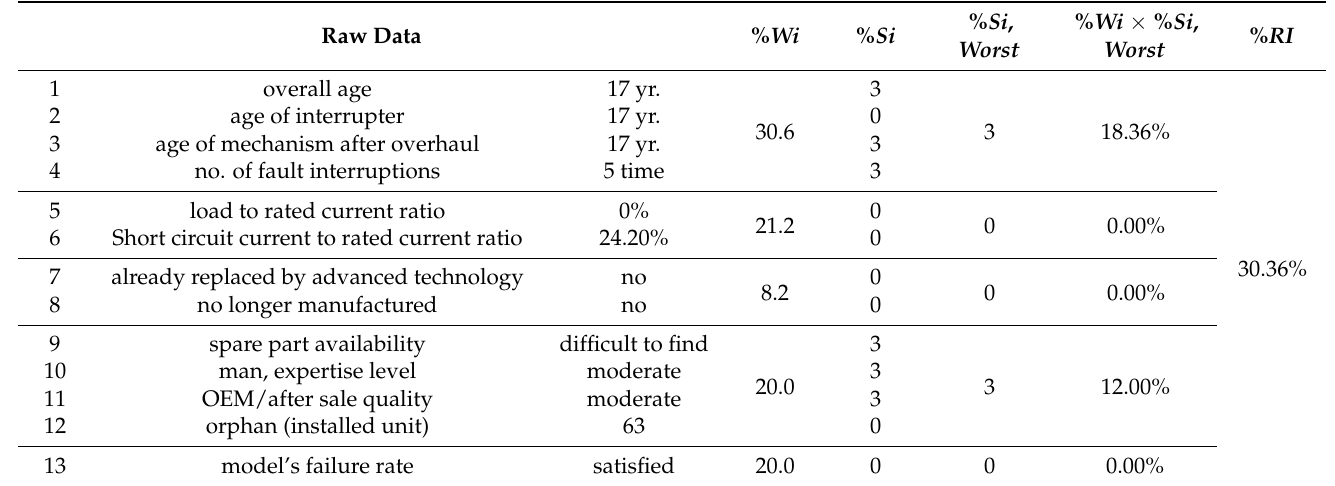
Table 9. Renovation index determination of HVCB#2 by using actual data and test results.